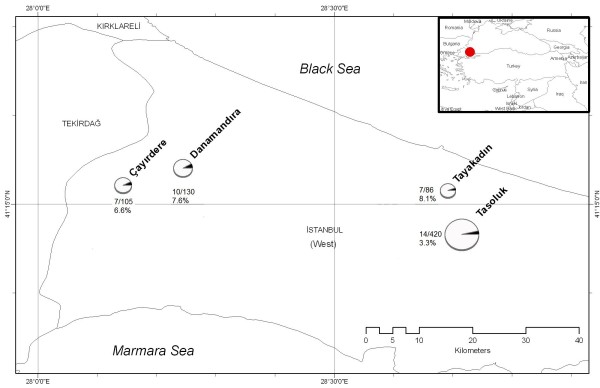
Distribution of CCHF IgM positive individuals in the region.